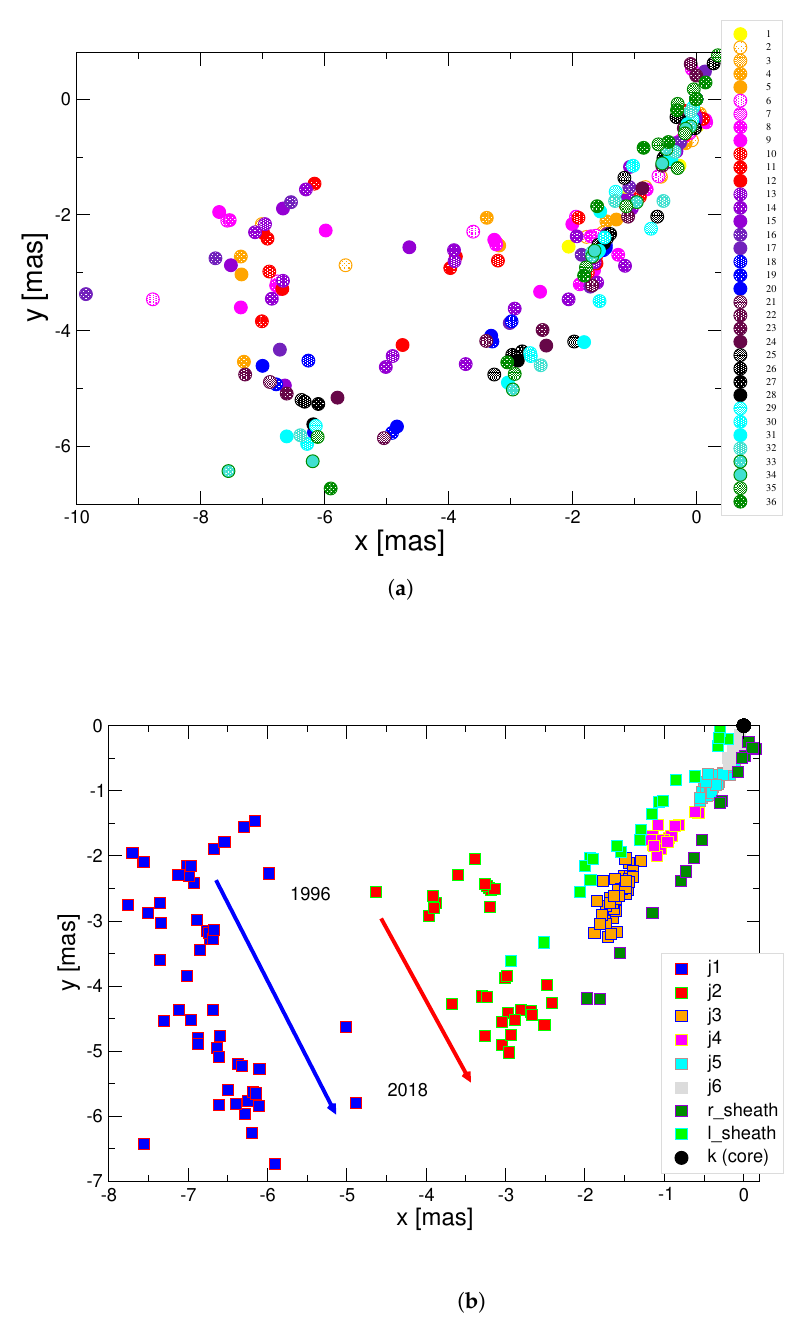
Figure 2. ( a ) The evolution of the x-y coordinates of the jet features modeled for all of the 36 epochs. The different epochs are indicated with different colors (1: the first/earliest epoch, 36: the lat- est/youngest epoch). ( b ) Same figure as in ( a ), but showing only those features that could be identified and tracked across the epochs. In addition to the jet features (j3 − j6), which most likely define the spine, we indicate in light-green and purple those jet components that might belong to the sheath (l_sheath, r_sheath). The two outermost jet features (j1 and j2) are clearly seen to move, and their motion is indicated by arrows along which the range and progression of the epochs covered are also